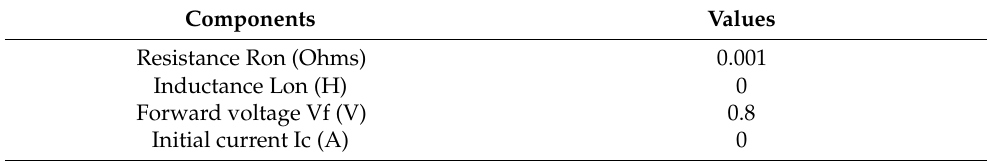
Table 6. Diode specifications of the converter.